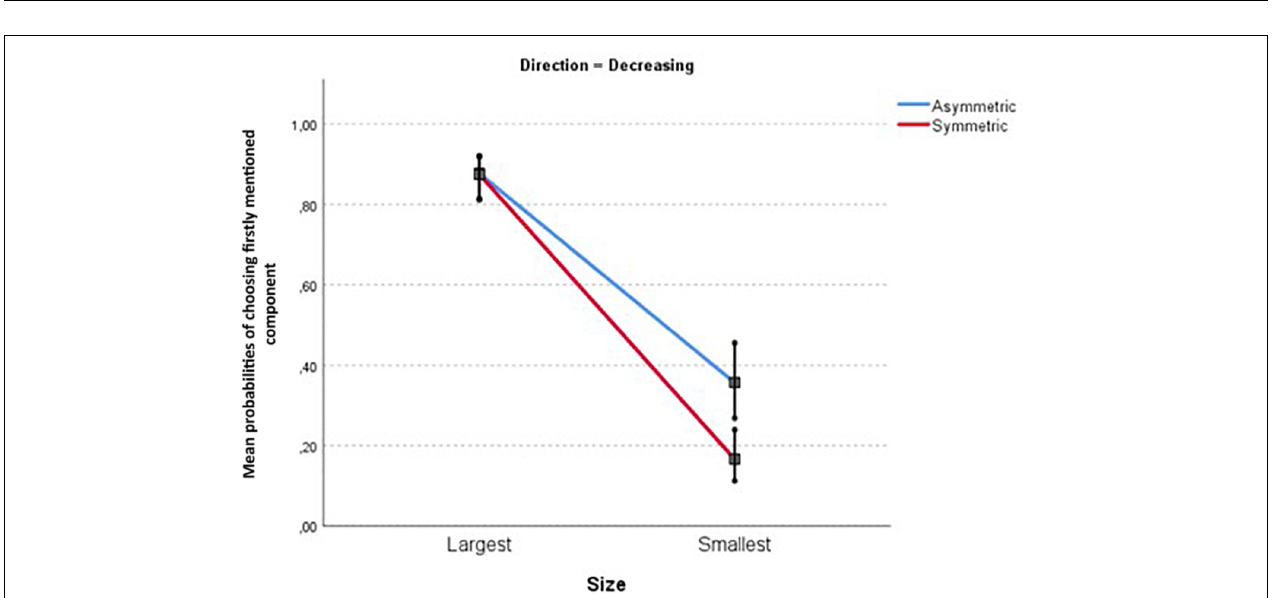
FIGURE 5 | Mean probabilities for the Size × Symmetry contrast for increasing proportions (see rows 1–4 in Table 3 ). Note: I indicate 95% confidence intervals.